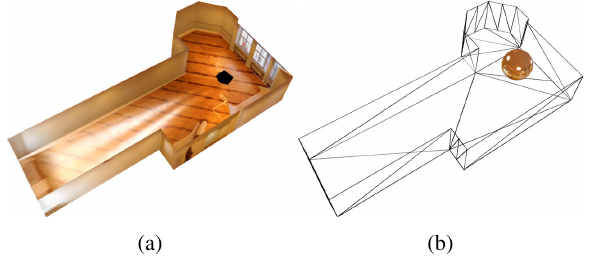
Figure 9: Our workflow is able to handle rooms with non- orthogonal geometry, as long as all important aspects can be scanned from one position.